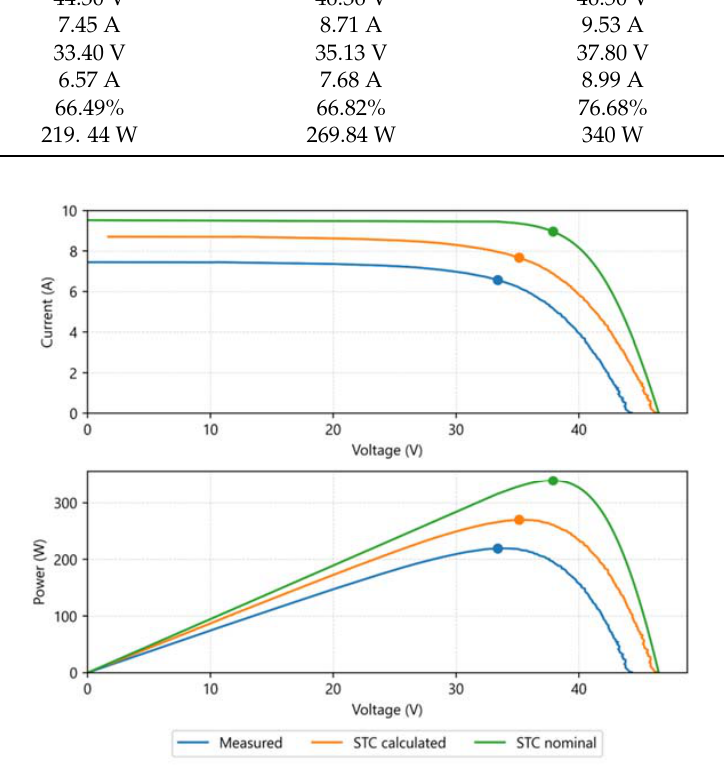
Figure 16. I ‐ V and P ‐ V curves of the PV module 2 (washed).